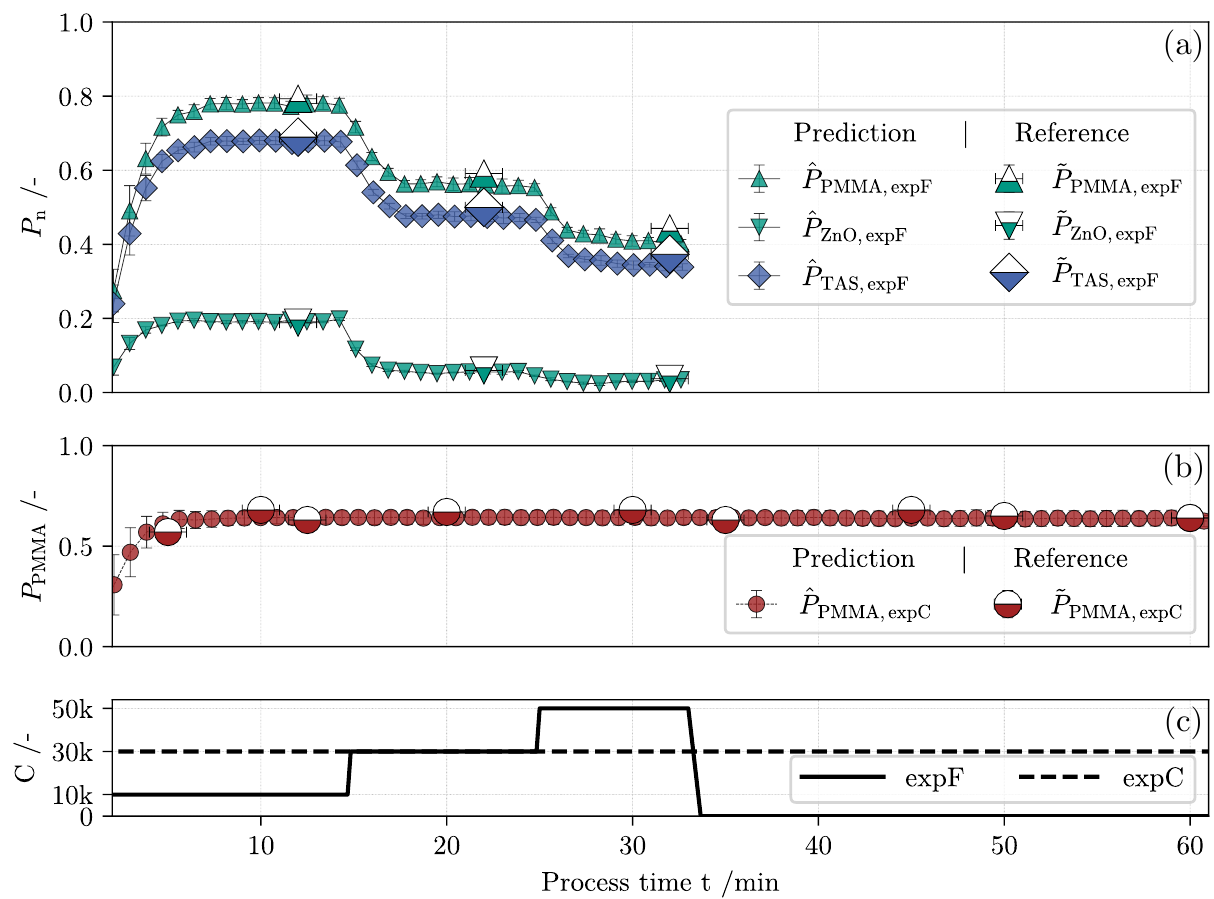
Figure 9. Comparison of sensor output (solid symbols) and laboratory analysis (half-filled symbols) of the product loss in fractionation ( a ) and classification ( b ) monitoring over the elapsed process time. The set centrifugation number is drawn on shared abscissa ( c ). The soft sensor output is based on the corresponding calibration data set of feature range